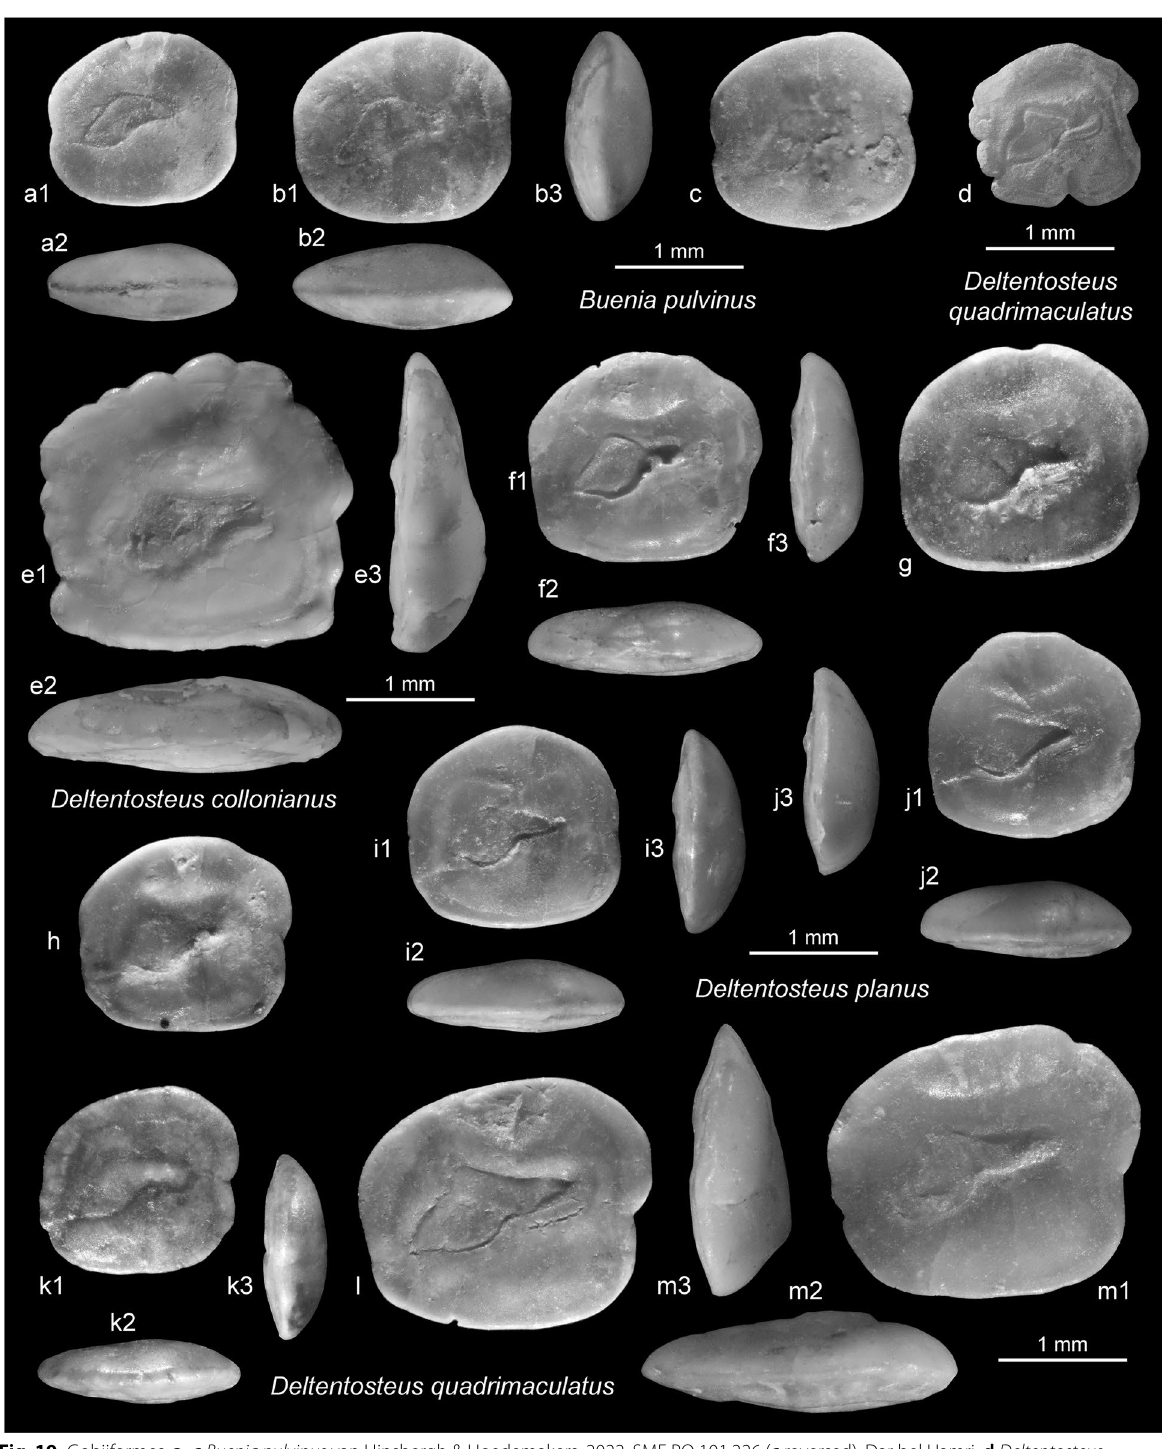
Fig. 19 Gobiiformes. a – c Buenia pulvinus van Hinsbergh & Hoedemakers, 2022, SMF PO 101.226 ( c reversed), Dar bel Hamri. d Deltentosteus quadrimaculatus (Vlenciennes, 1837), extant, ICM-O 132.8 from the Catalanian sea, Spain, TL 32 mm. e Deltentosteus collonianus (Risso, 1820), = extant, ZMUC 14, Mediterranean 8.12.1891. f – j Deltentosteus planus n. sp. Dar bel Hamri, Zanclean, f holotype, SMF PO 101.227, g – j paratypes, SMF PO 101.228 ( h , j reversed). k – m , Deltentosteus quadrimaculatus (Valenciennes, 1837), SMF PO 101.229 (reversed), Dar bel